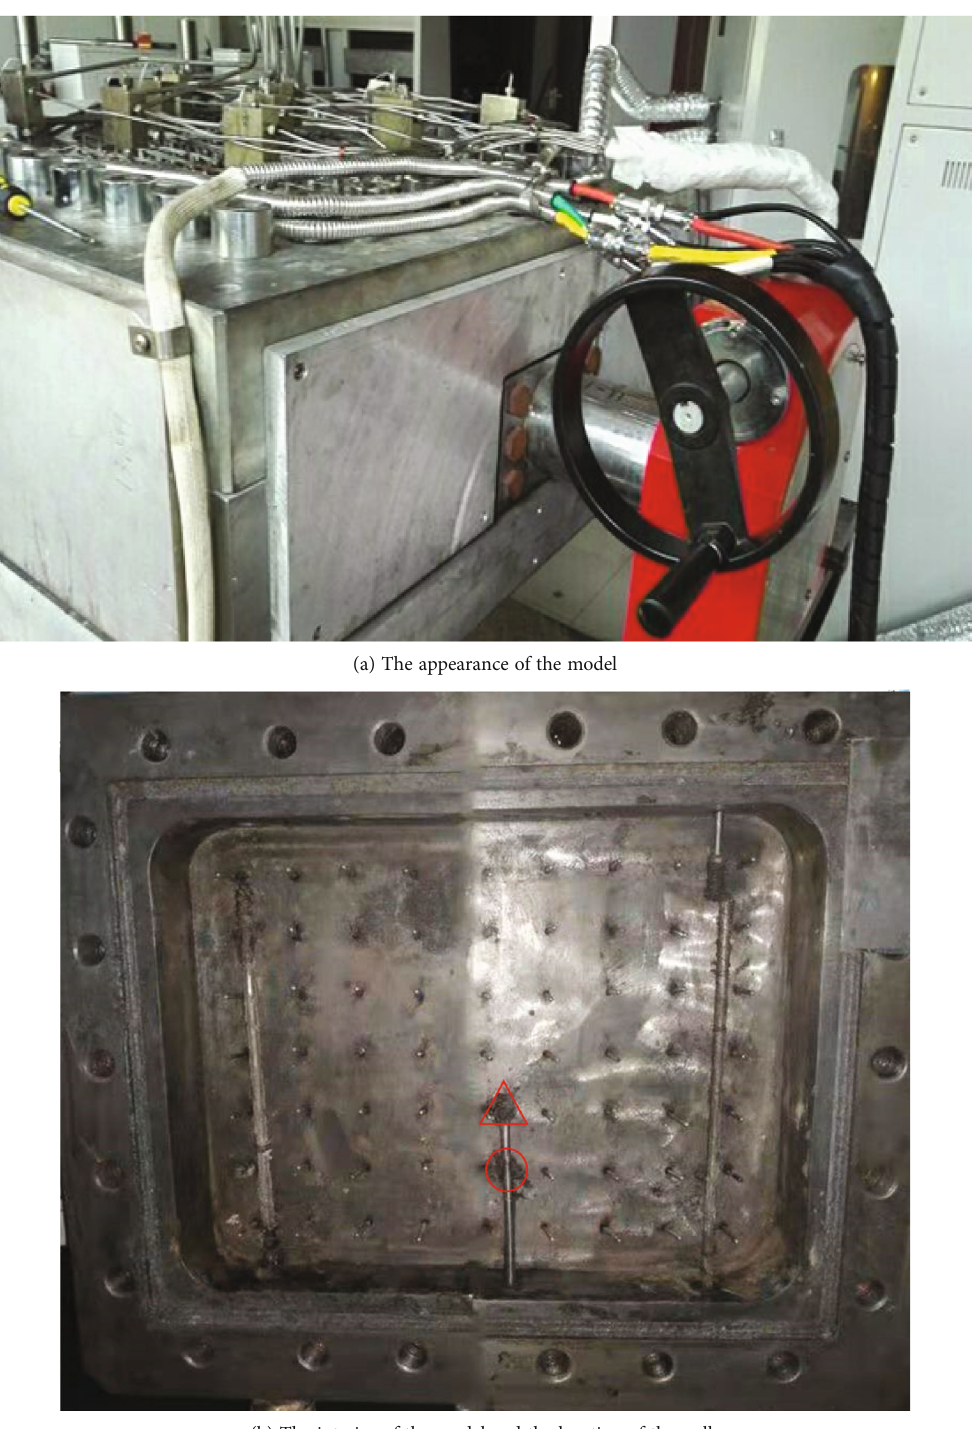
Figure 2: Physical simulation